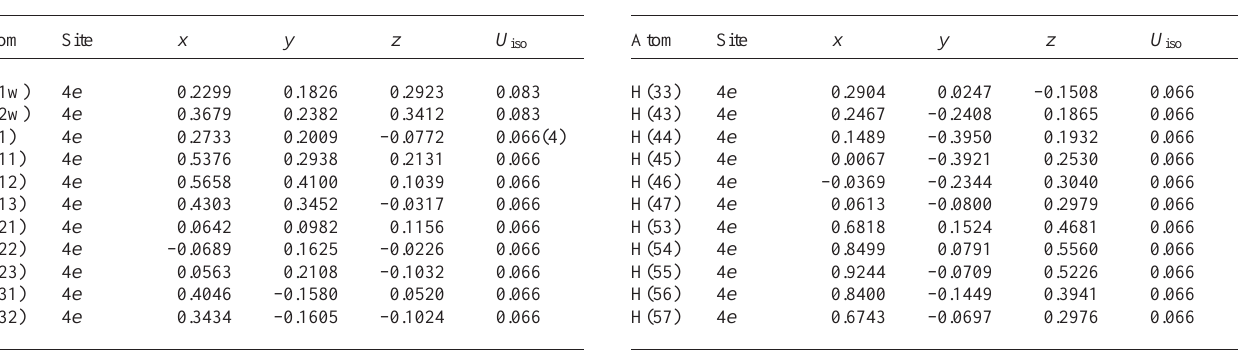
Table 2. Atomic coordinates and displacement parameters (in Å 2 )